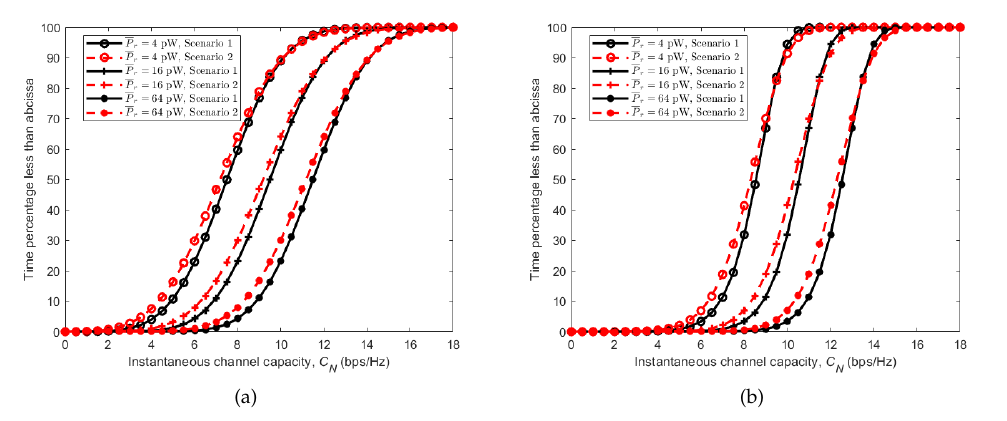
Figure 12. CDFs of channel capacity C for different average received power P r . ( a ) running; ( b ) cycling.